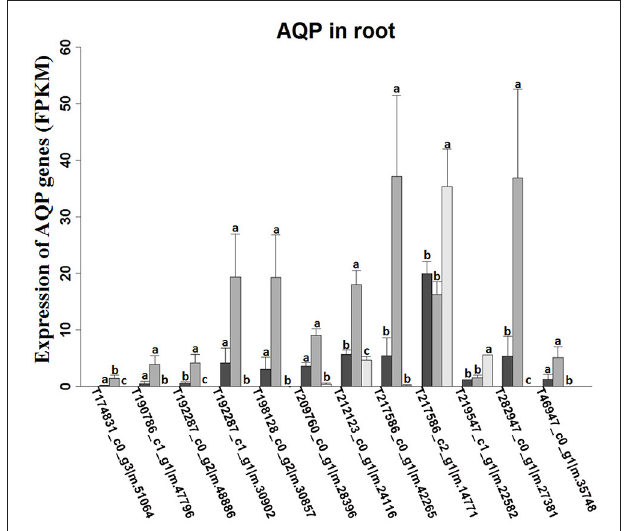
FIGURE 4 | Expression levels of aquaporin-like unigenes in roots of K. sieversiana under different salinity treatments. The values are means of three replicates ( ± SE). The 30-d-old seedlings were subjected to 0, 80, and 480mM NaCl for 2 d. Different letters above the bars indicated significant differences among treatments, according to a least significant difference test ( P ≦ 0.05). FIGURE 5 | Effects of salinity stress on the Na + content (A) , K + content (B) ,